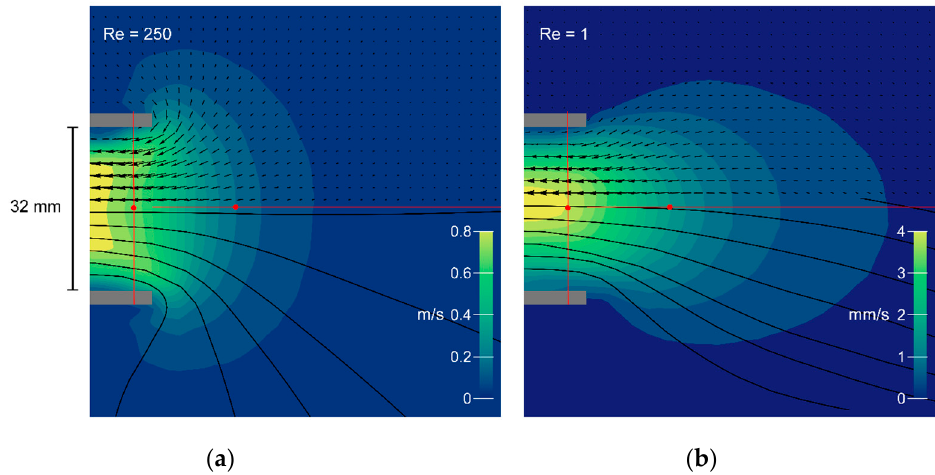
Figure 4. Flow fields generated by the mechanical model at Re = 250 ( a ) and Re = 1 ( b ). Magnitudes are represented by color contours; flow direction is indicated by vectors and streamlines in black. Grey bars show the nozzle in cross section (inner diameter 32 mm). The axial and radial transects are illustrated in red, and the corresponding vector magnitudes are plotted in Figure 5a–c below).